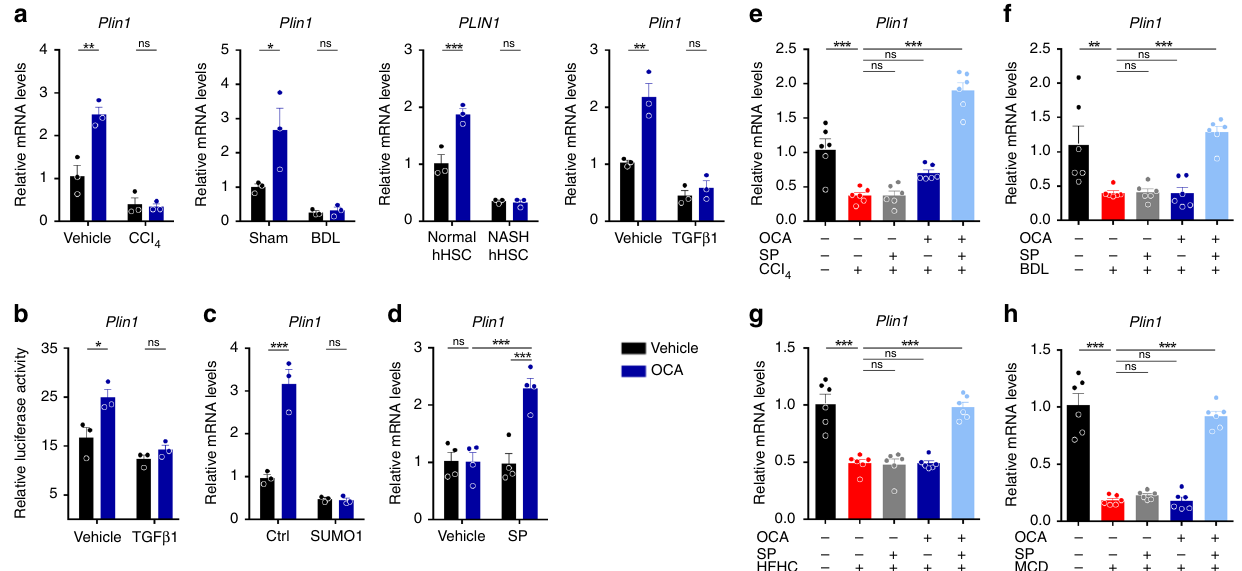
Fig. 10 SUMOylation of FXR represses Plin1 transcription. a OCA failed to upregulate the Plin1 mRNA in activated HSCs caused by CCl 4 treatment, BDL operation and from NASH patients ( n = 3 biologically independent samples within these experiments). b OCA failed to promote the induction of Plin1 in activated HSCs as re fl ected by reporter gene assays ( n = 3 biologically independent samples). c SUMOylation of FXR inhibited the transcription of Plin1 ( n = 3 biologically independent samples). d SP rescued the regulation of OCA on Plin1 in cultured HSCs ( n = 4 biologically independent samples). e – h SP treatment restored the regulation of OCA on Plin1 in isolated HSCs from CCl 4 e , BDL f , HFHC g , or MCD h mice ( n = 6 biologically independent samples within these experiments). Results are mean ± SEM, * P < 0.05, ** P < 0.01, and ns, statistically not signi fi cant, as assessed with